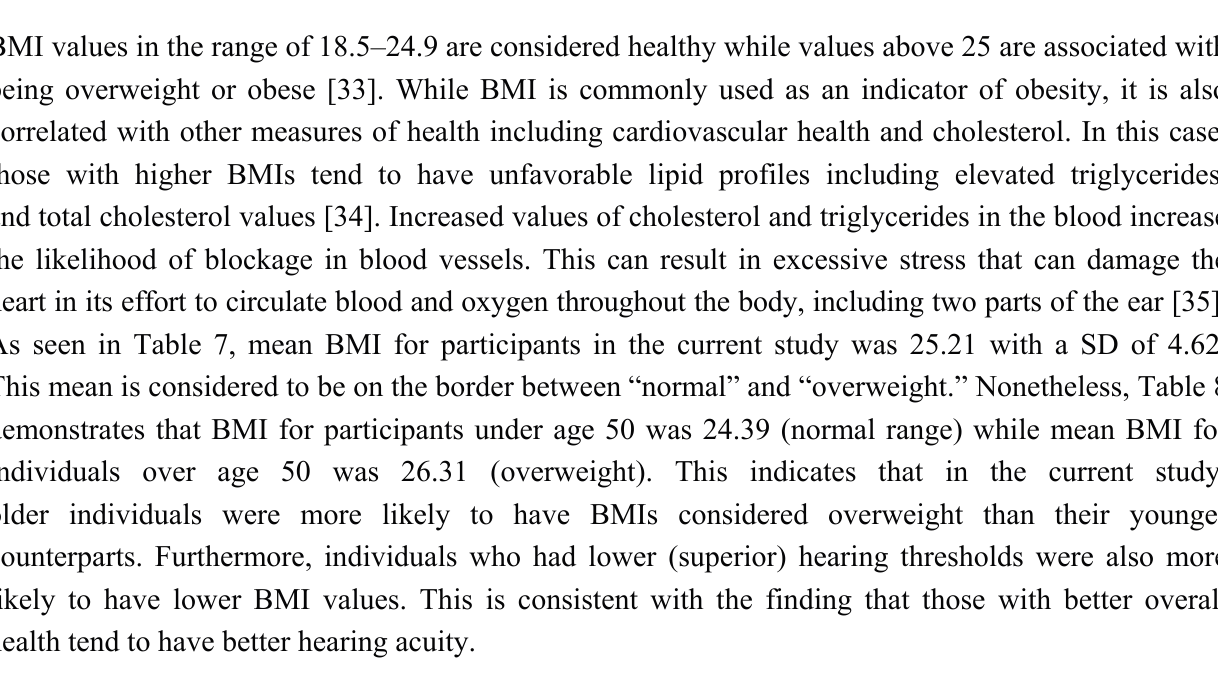
Table 7. Mean measures of health-related variables across participants.